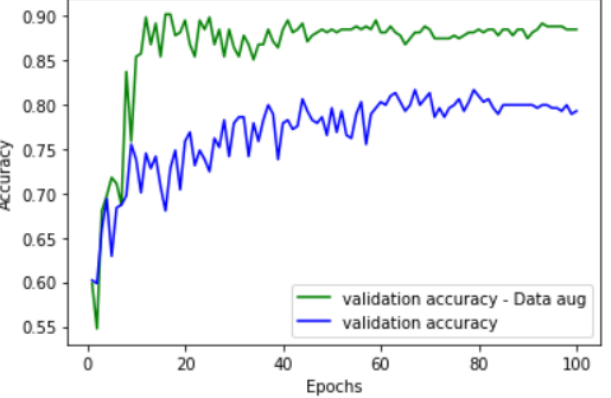
Figure 13. Validation accuracy with and without data